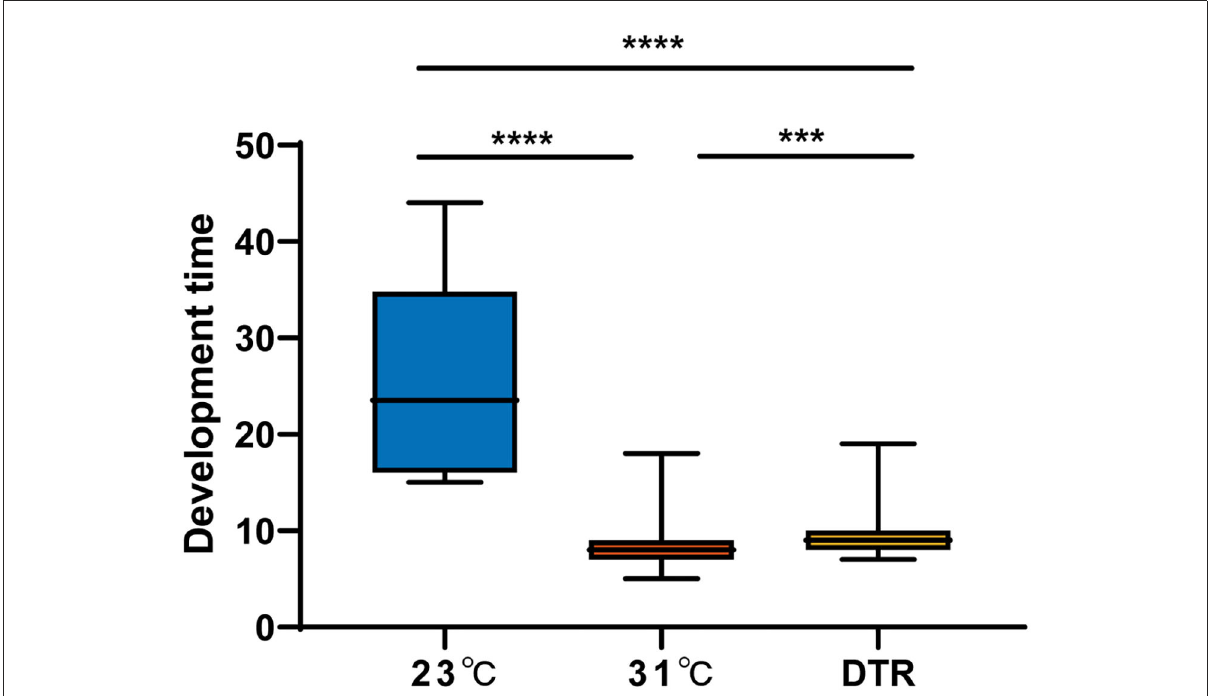
FIGURE3 The development time of Ae. albopictus (F1) at different temperatures. The larvae development time was defined as the time from the second day of hatching to the day of pupation. Box plots show the median and the 25–75th percentiles, and the whiskers denote the maximum and minimum values. Data were analyzed by the Kruskal–Wallis test with Dunn’s multiple comparisons test. N = 1,108–259. *** P < 0.001, **** P < 0.0001.